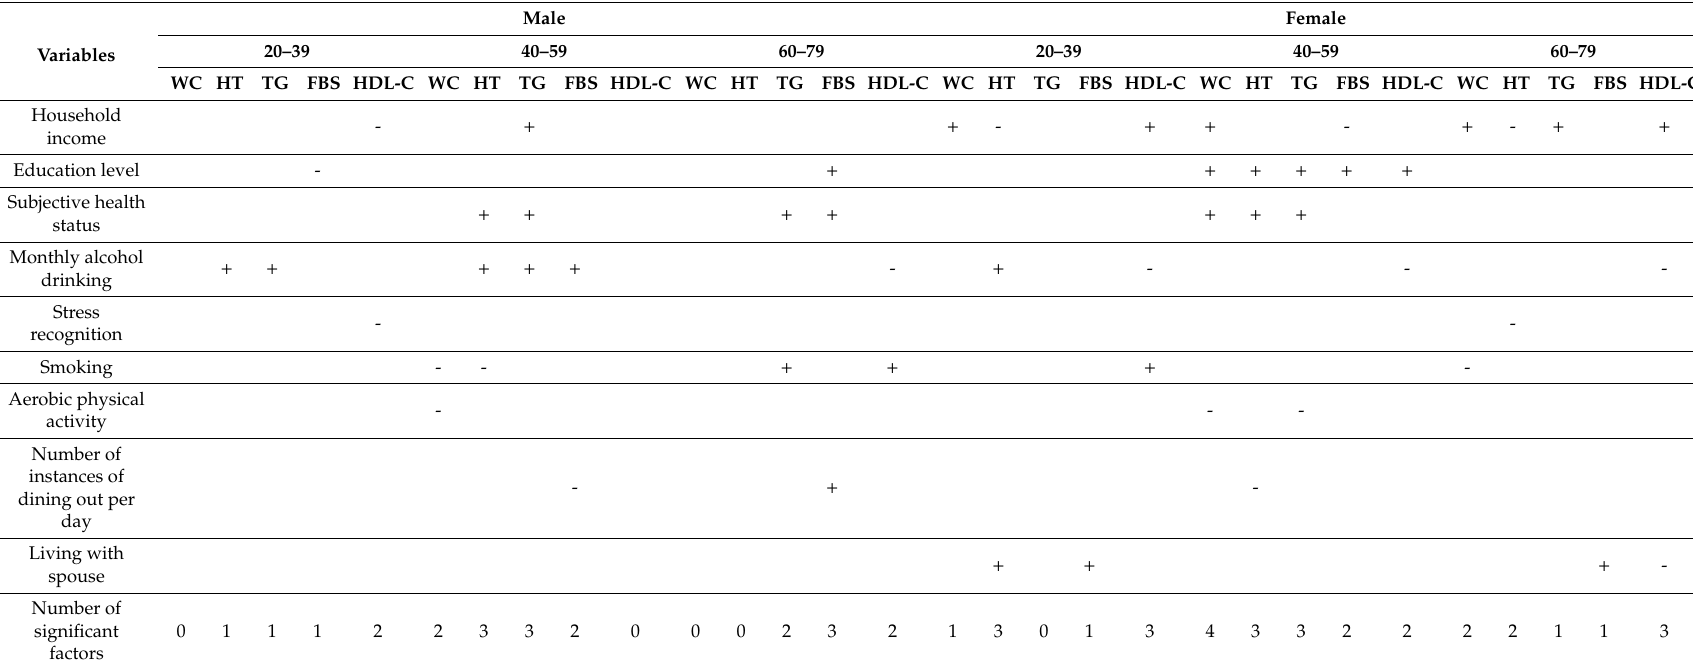
Table 5. The number of significant risk factors associated with di ff erent components of metabolic syndrome in the di ff erent age groups of both